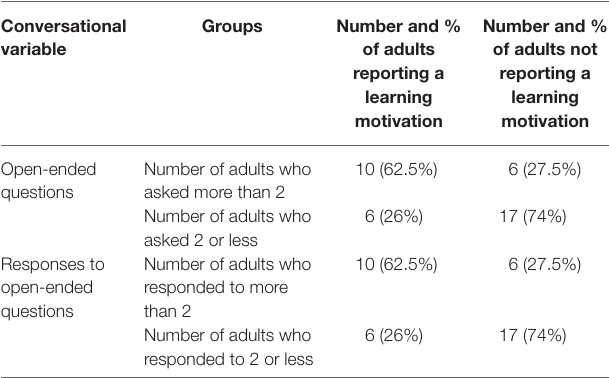
TABLE 2 | Median and range for the total number of conversational codes for children and parents. Conversational variables